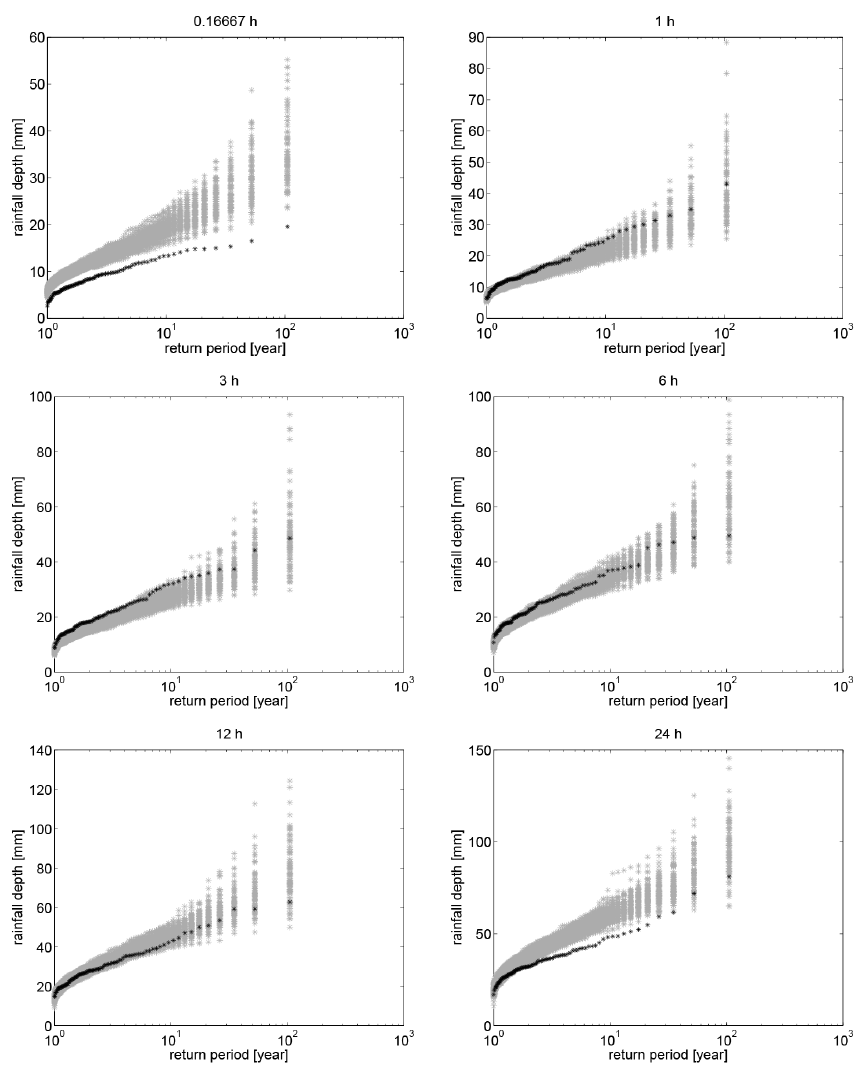
Figure 9. Comparison of empirically derived annual maxima related to the empirical return periods for different aggregation levels on the observed (black asterisks) and ensemble of synthetic time series generated by means of the copula-based rainfall model (grey